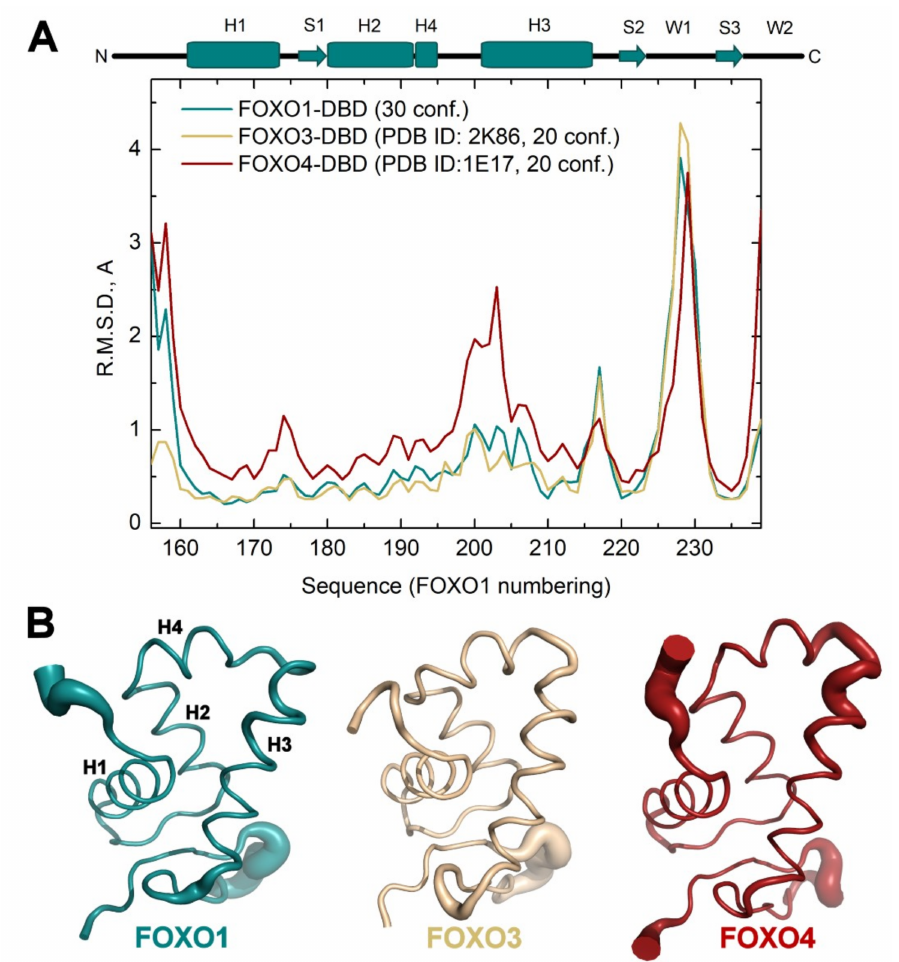
Figure 5. Conformational flexibility of FOXO-DBDs. ( A ) Root Mean Squared Deviation (R.M.S.D.) di ff erence from average as a function of the sequence of FOXO1-DBD, FOXO3-DBD (PDB ID: 2K86 [46]) and FOXO4-DBD (PDB ID: 1E17 [45]). RMSD profiles were calculated using the MOBI server [50]. Secondary-structure elements (based on the FOXO1-DBD) are indicated at the top. ( B ) Sausage representation of NMR ensembles of FOXO1-DBD, FOXO3-DBD and FOXO4-DBD. The backbone diameter indicates the conformational